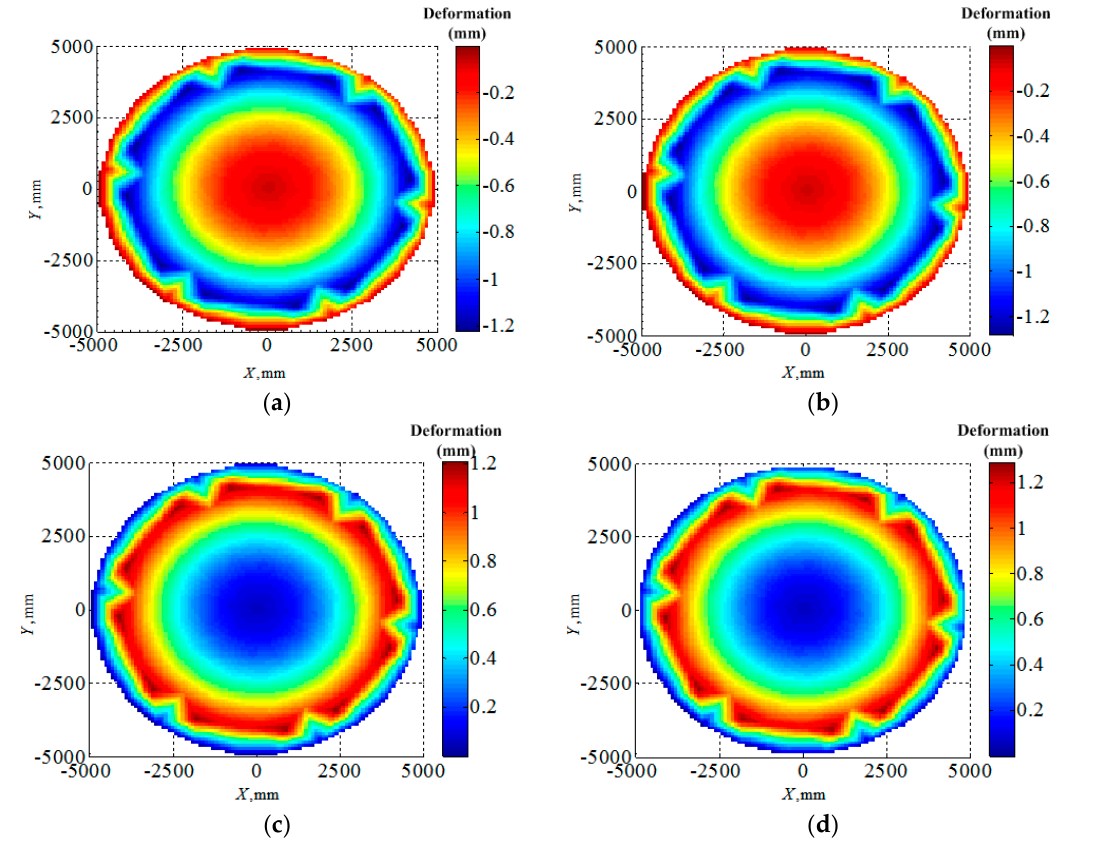
Figure 5. Comparison of the thermal deformation computed by the FEI method in this work and ANSYS: ( a ) Thermal deformation by FEI under 140 °C, ( b ) thermal deformation by ANSYS under 140 °C, ( c ) thermal deformation by FEI under − 100 °C and ( d ) thermal deformation by ANSYS under − 100 °C.